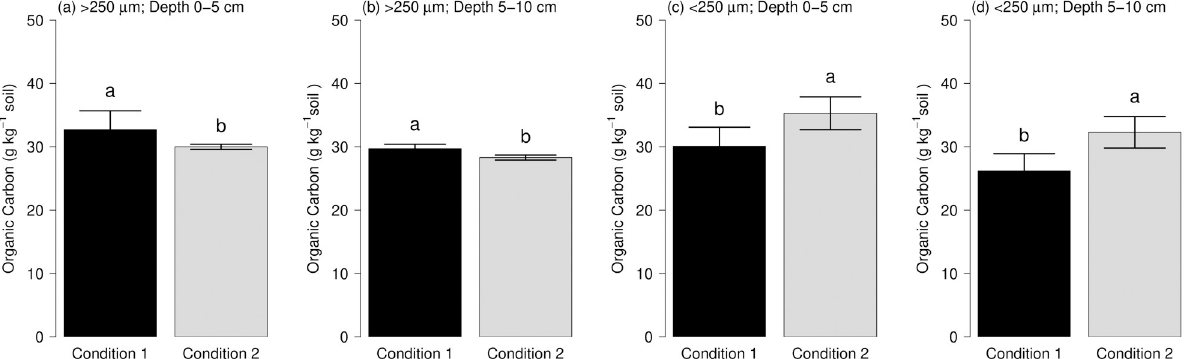
Fig 3. Content of organic carbon associated with soil macro ( > 250 μ m) and microaggregated ( < 250 μ m) at two soil depths in lacustrine soil studied. Barplot (a) and (b) represent > 250 μ m aggregates at 0–5 and 5–10 cm, respectively. Correspondingly, barplot (c) and (d) represent < 250 μ m aggregates at 0–5 and 5–10 cm, respectively. Different letters indicate statistically significant differences at the 0.05 level by Tukey’s post-hoc test.